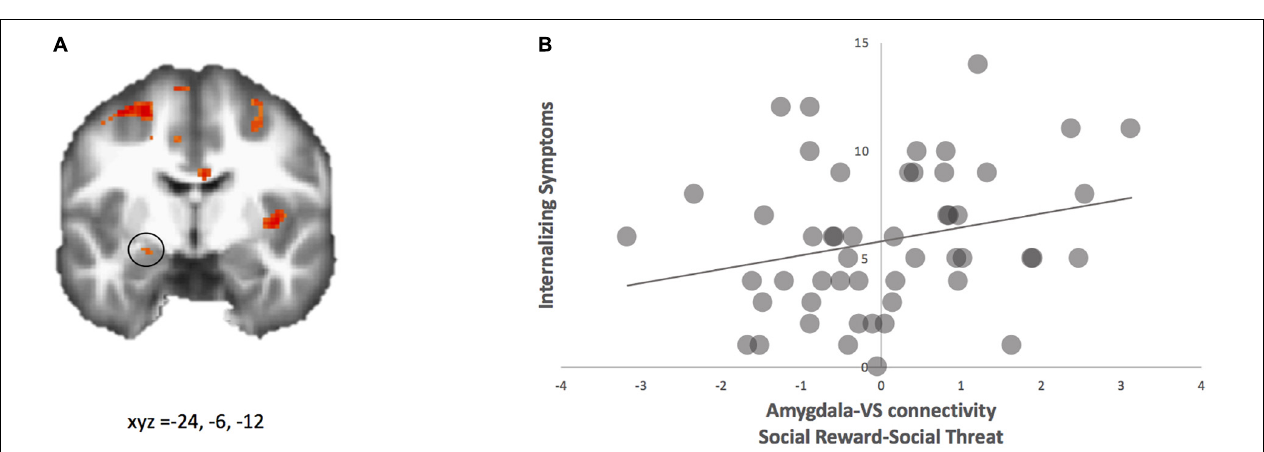
FIGURE 3 | PPI analysis with ventral striatum seed. (A) Adolescents with greater false alarm rate to social reward-social threat trials showed greater functional connectivity between the ventral striatum and amygdala (highlighted; MNI coordinates: x, y, z = –24, –4, –14) for social reward > social threat. (B) Parameter estimates of connectivity strength were extracted for descriptive purposes and plotted with false alarm rate.